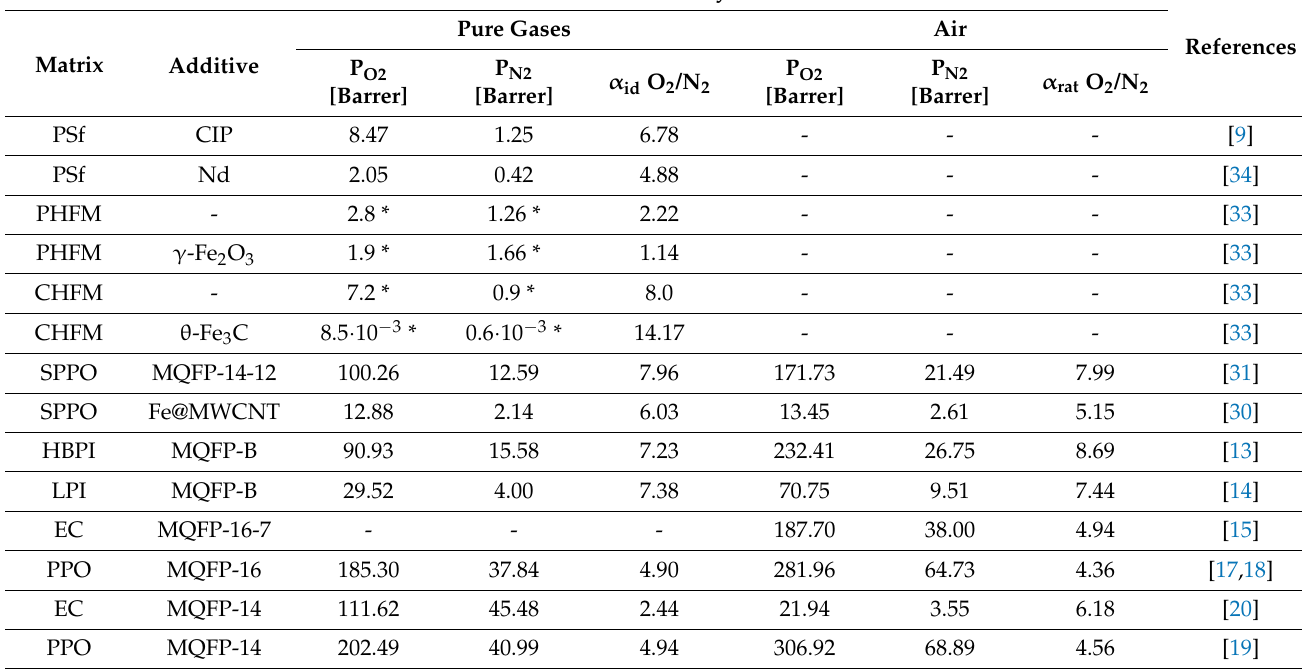
Table 1. Permeability (P) and selectivity coefficients ( α ) determined for pure oxygen and nitrogen, as well as in air for various magnetic